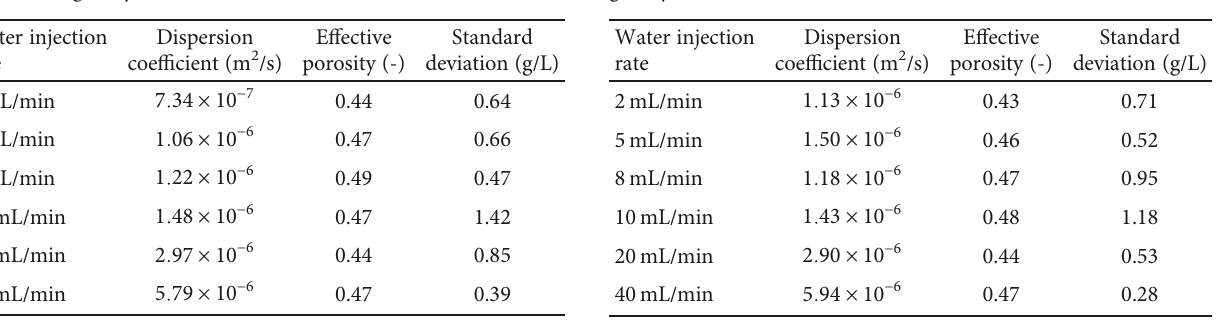
Figure 6: The dimensionless curve of concentration variation at the outlet for each contrast tests: (a) 20 mL/min, (b) 10mL/min, (c) 5mL/min, and (d) 2mL/min. Table 2: Parameter optimization and error analysis along the direction of gravity.